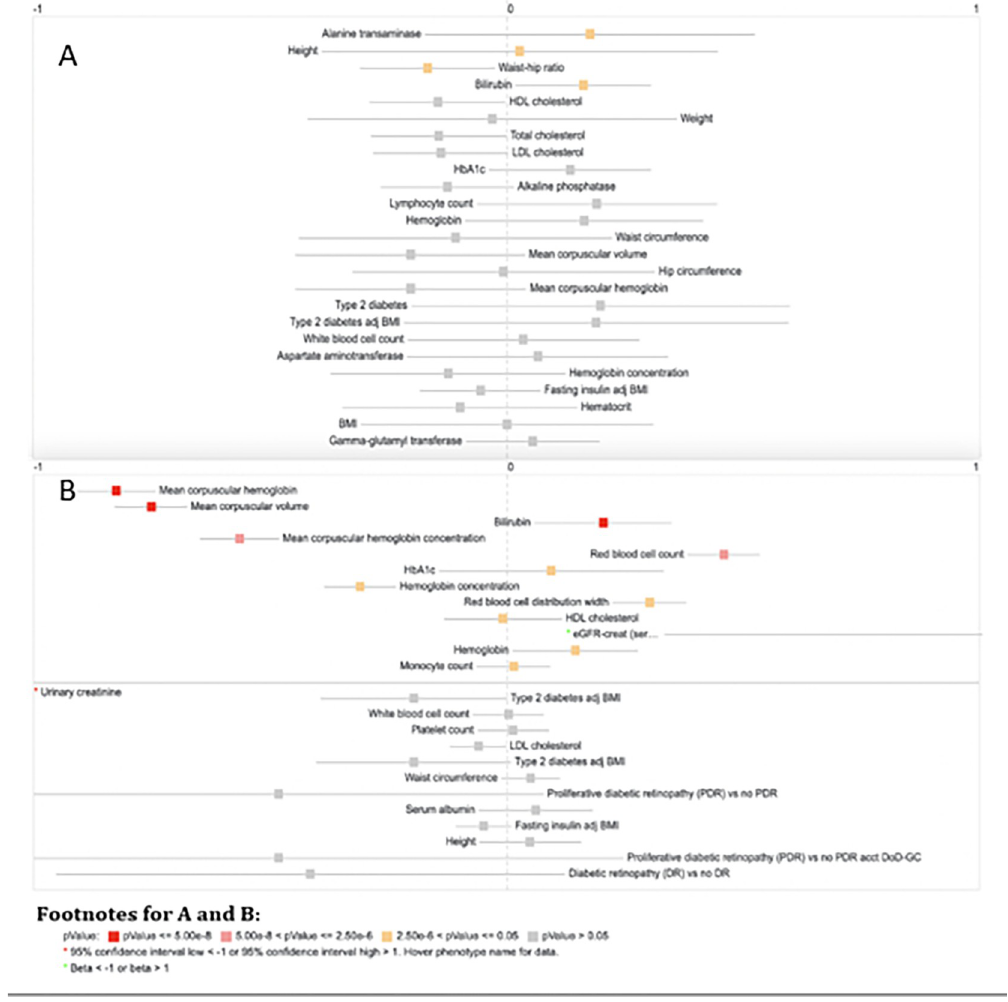
Fig 3. PheWAS forest plot of the top traits associated with the lead GWS loci in the UGR cohort (A) Chr 8 (rs374279268) and (B) Chr 16 (rs148110594).